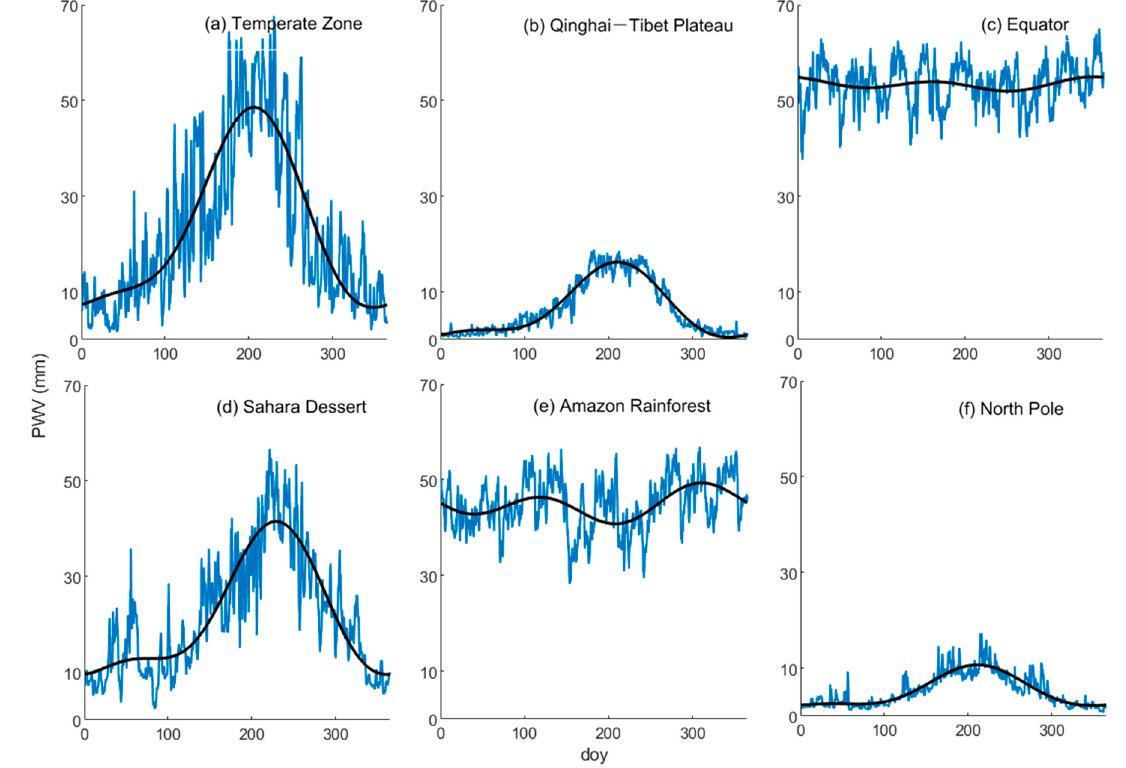
Figure 2. Variation of precipitable water vapor (PWV) in the selected six regions during 2018. doy, day of year: ( a ) Temperate Zone ( b ) Qinghai—Tibet Plateau ( c ) Equator ( d ) Sahara Dessert ( e ) Amazon Rainforest ( f ) North Pole.